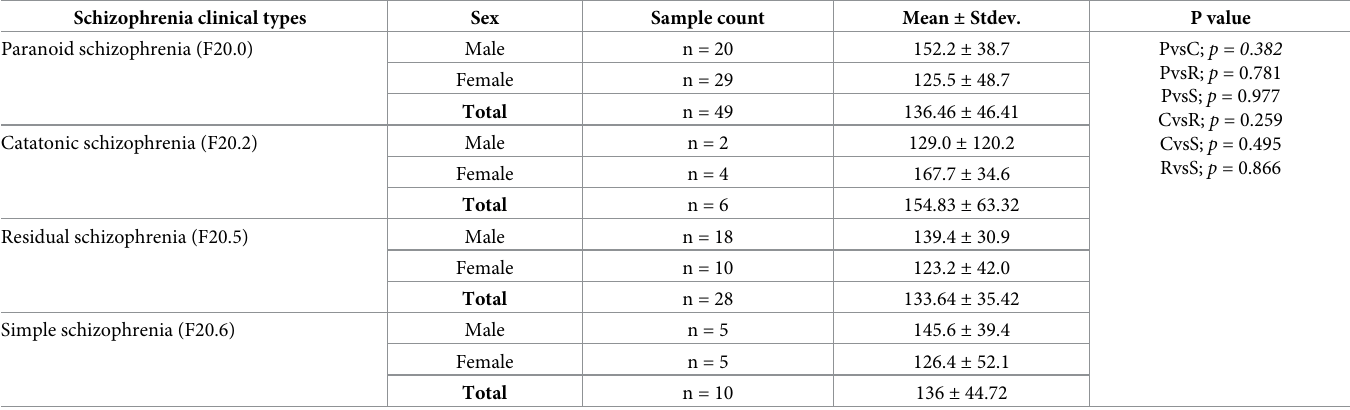
Table 5. Mean of total finger ridge count by schizophrenia clinical